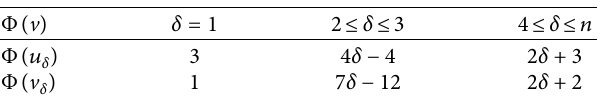
Table 9: Vertex labeling of Φ ( v ).